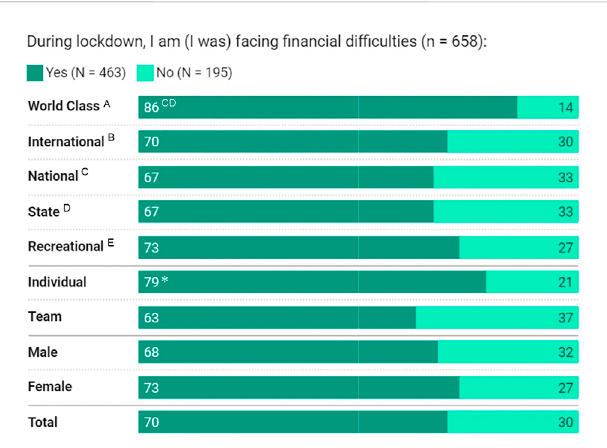
FIGURE 6 Financial challenges during lockdown based on athlete classi fi cation, sport-type,gender,and totalcohort;data are presented in percentage. CD Signi fi cantly higher than National and State, *signi fi cantly higher at p < .05 (within the speci fi c comparative